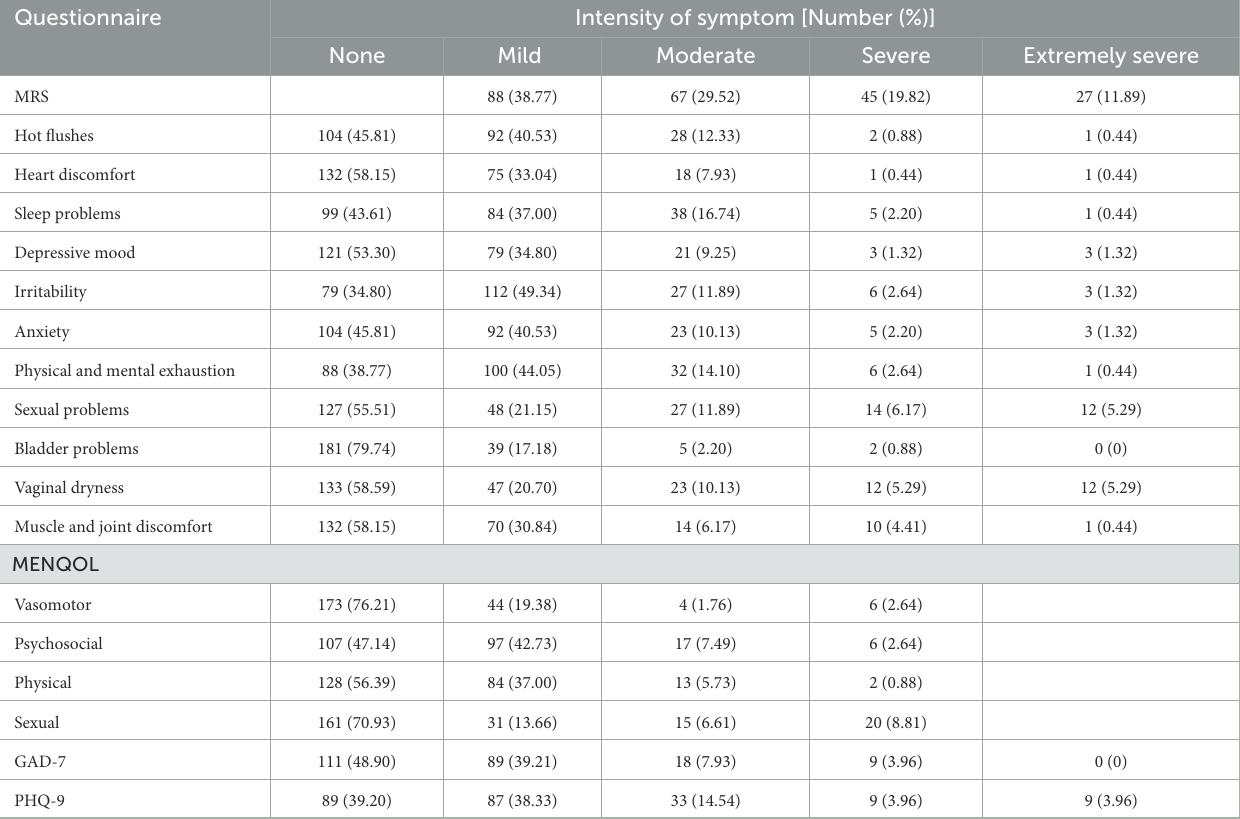
TABLE 2 The severity of menopausal symptoms among participants after HSCT.